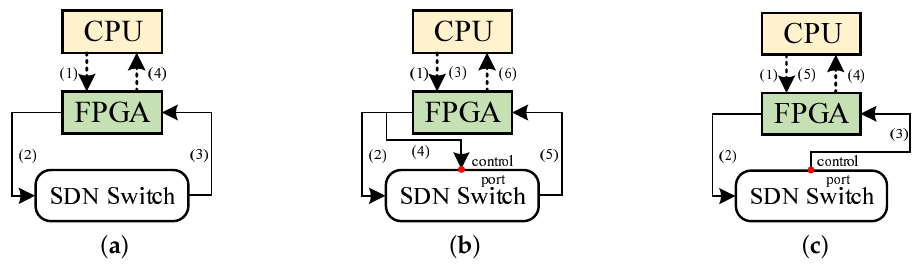
Figure 2. The workflow of the CFT; ( a ) performance, ( b ) correctness (actively), ( c ) correctness